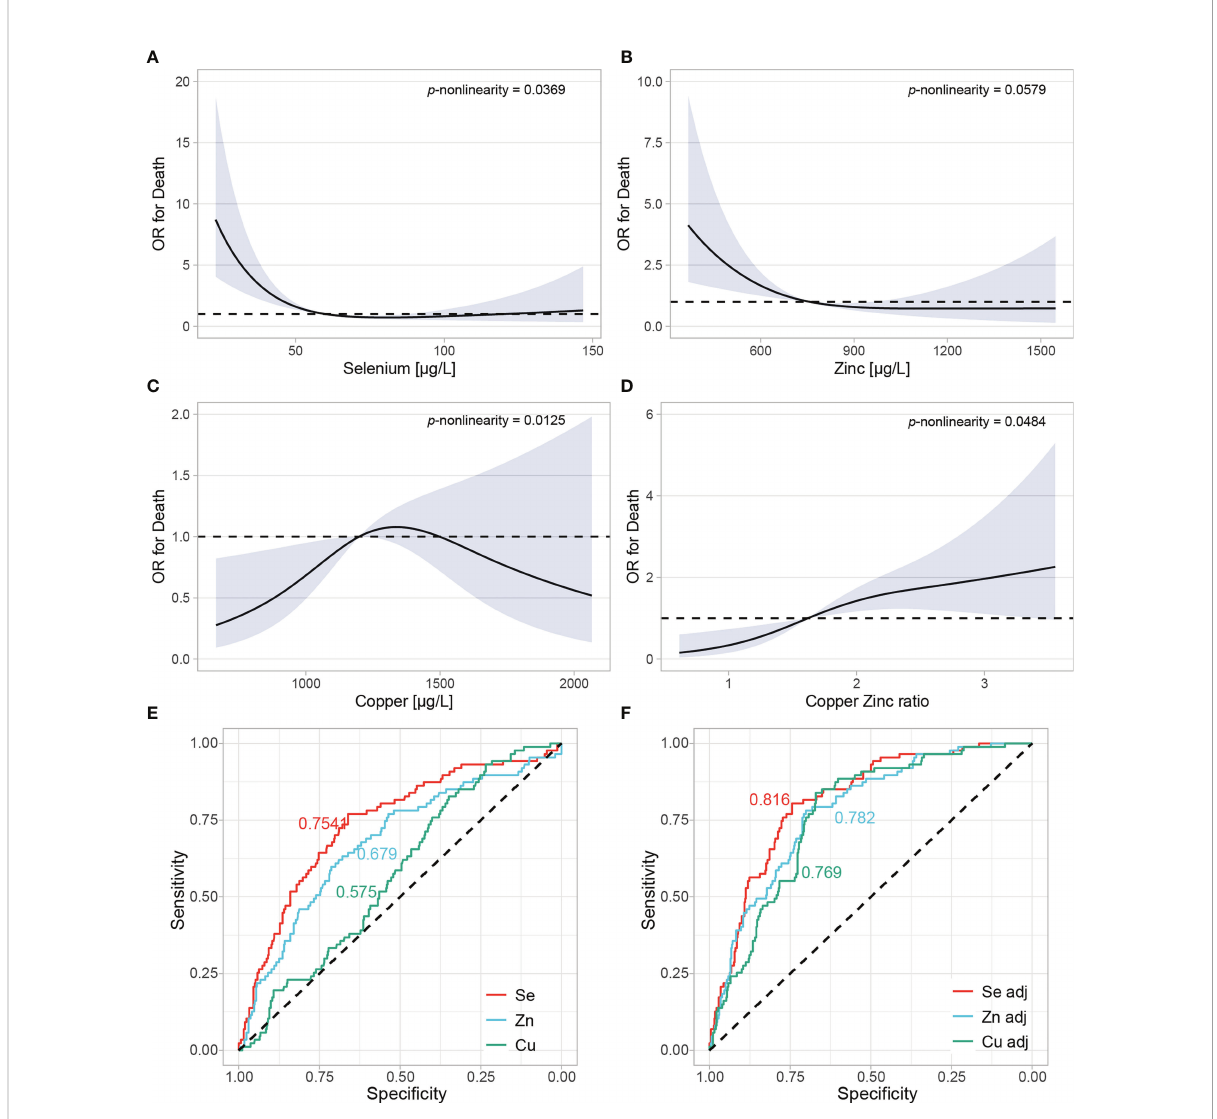
FIGURE 5 Adjusted restricted cubic spline regression in a pool of all patients from all countries. (A – D) Restricted cubic spline regression with three knots at 10 th , 50 th and 90 th centiles were conducted to assess the relationship between trace elements and odds ratio (OR) of death. All analyses were adjusted for age, sex, and country of the samples. P for nonlinearity was calculated by comparing nested linear regression models to the restricted cubic splines by likelihood ratio X 2 test. (E) Se, Zn and Cu were evaluated as individual predictors in relation to death using the restricted cubic spline model. Areas under the curves (AUC) are plotted for each predictor. (F) Models were further adjusted for age and